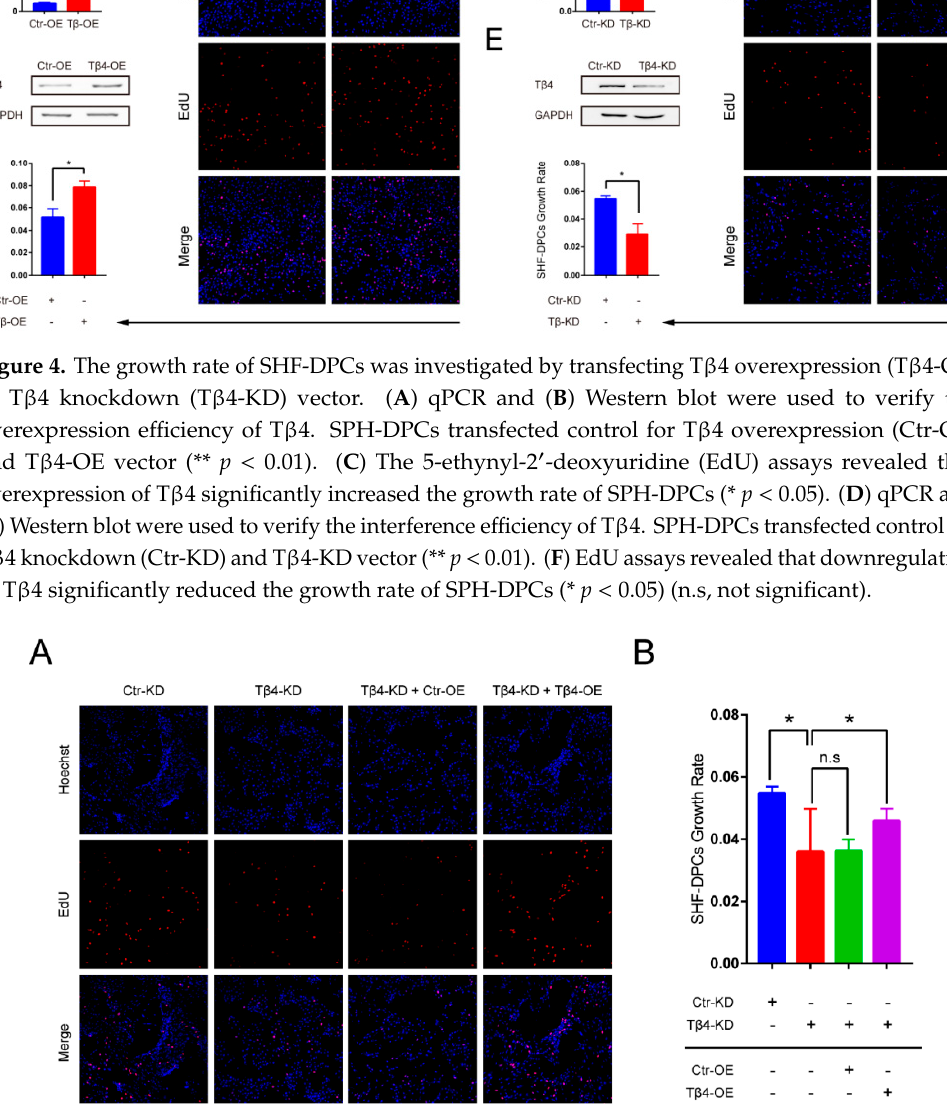
Figure 5. The growth rate of T β 4-KD-SHF-DPCs was rescued by transfecting T β 4-OE vector. ( A ) EdU staining was used to assess the proliferation of SHF-DPCs. ( B ) The percentage of EdU-positive SHF- DPCs was calculated (* p < 0.05).